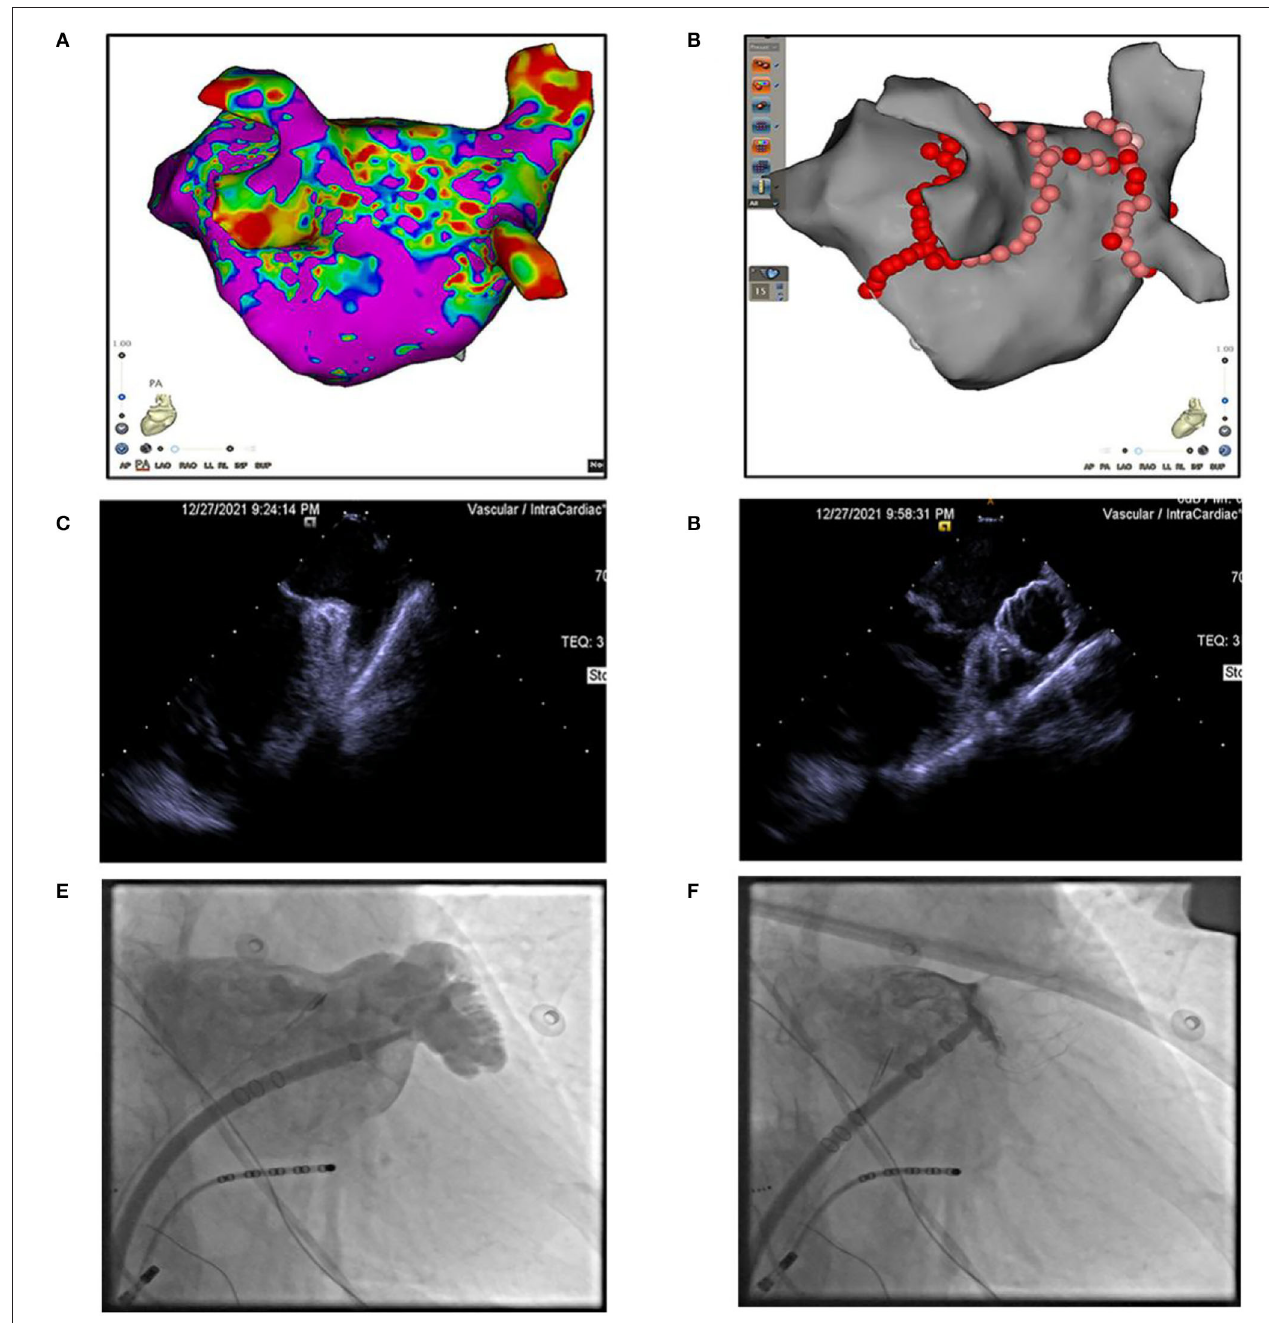
FIGURE 2 | (A) 3D modeling and substrate mapping of left atrium. (B) Catheter ablation at pulmonary veins, left atrium roof, and mitral isthmus. (C,D) Intracardiac echocardiography image of left atrial appendage (LAA) before or after LAA occlusion. (E,F) Fluoroscopy image of left atrial appendage (LAA) before or after LAA